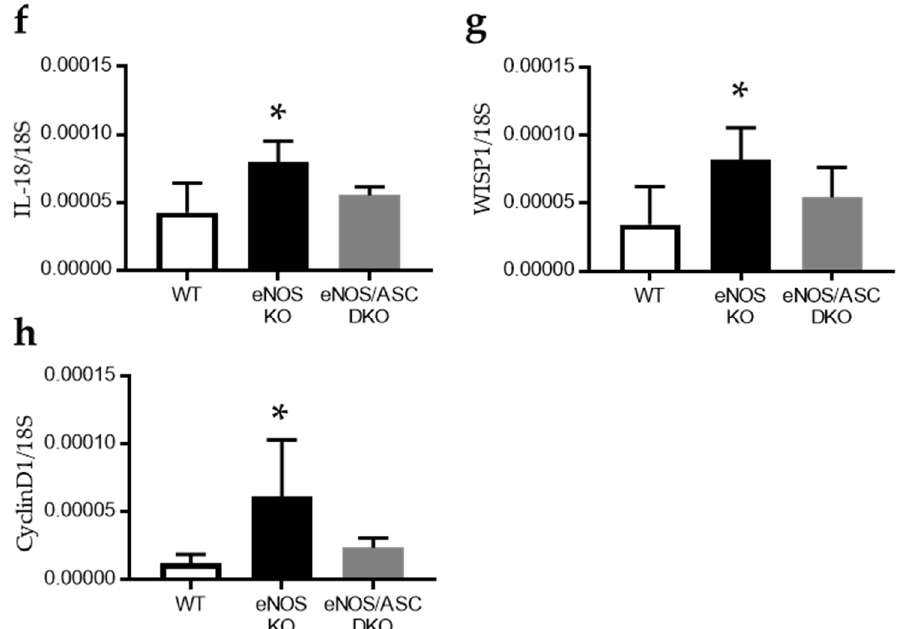
Figure 2. Evaluation of glomerular damage and inflammatory response in aged mice: ( a ) PAS staining of glomeruli. Bar = 50 µ m; ( b ) percentage of glomerular sclerosis; ( c ) measurement of U-Alb/U-Crn. mRNA expression of ( d ) ASC, ( e ) IL-6, ( f ) IL-18, ( g ) WISP1 and ( h ) CyclinD1. Data are expressed as means ± SD. WT, wild type ( n = 3–5); eNOS KO, eNOS KO mice ( n = 3–5); eNOS/ASC DKO, eNOS/ASC DKO mice ( n = 3–5); PAS, periodic acid–Schiff; U-Alb/U-Crn, urinary albumin/urinary creatinine. * p < 0.05 vs. WT, † p < 0.05 vs. eNOS KO.